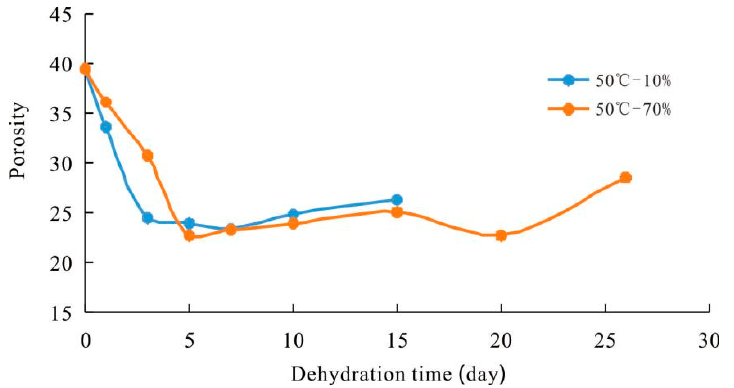
Figure 7. The variation of expansive soil porosity with dehydration time under two kinds of envi- ronmental